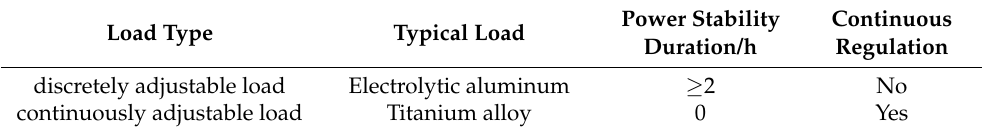
Table 1. Various types of energy-intensive load regulation